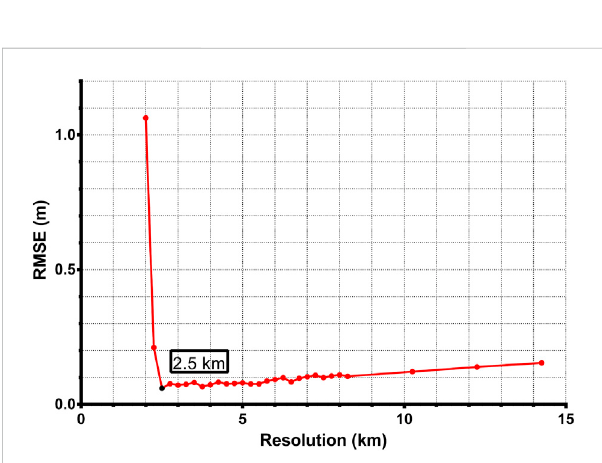
FIGURE 5 A trade-off curve between RMSE and window size in SM-VCE